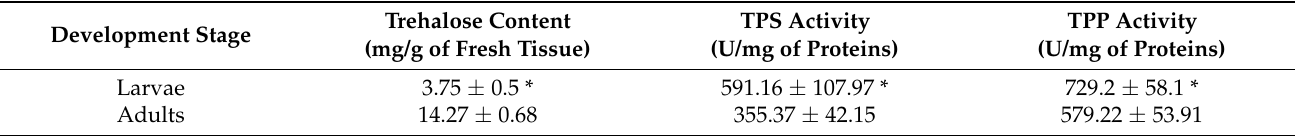
Table 1. Content of trehalose and optimal activities of trehalose-synthetizing enzymes from Cystidicola farionis (Mean ±